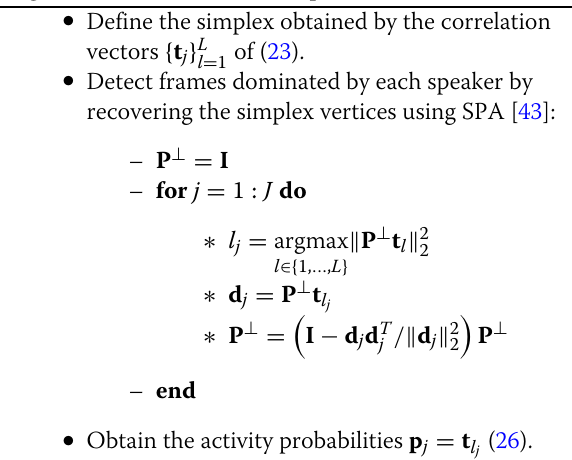
Algorithm 2: Correlation Simplex